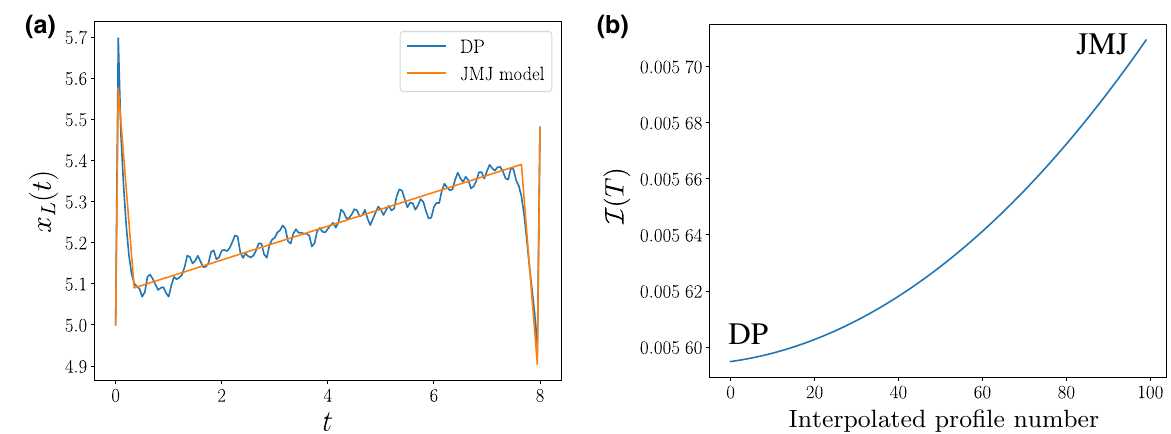
FIG. 14. (a) The DP optimized majorana motion strategy in regime (III) ( T = 8, l = 0.48 ) on top of the optimized (scans over the free parameters) JMJ model strategy. The optimal JMJ model strategy captures the main features (jumps) of the DP strategy well. (b) Infidelity I ( T ) obtained for 100 linearly interpolated profiles between the DP strategy and JMJ model strategy as shown in (a). We observe a convex decreasing function towards the more flexible DP result.